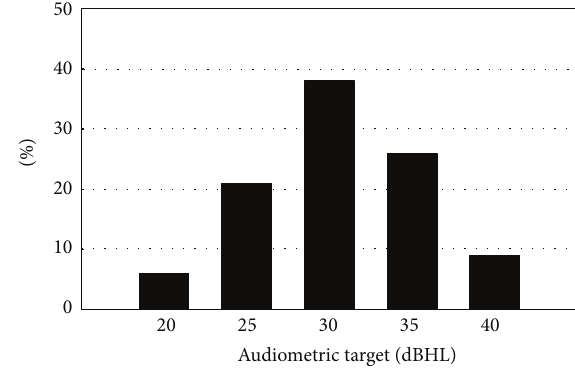
Figure 6: Histogram showing the frequency of the reported audio- metric targets (dBHL) at different